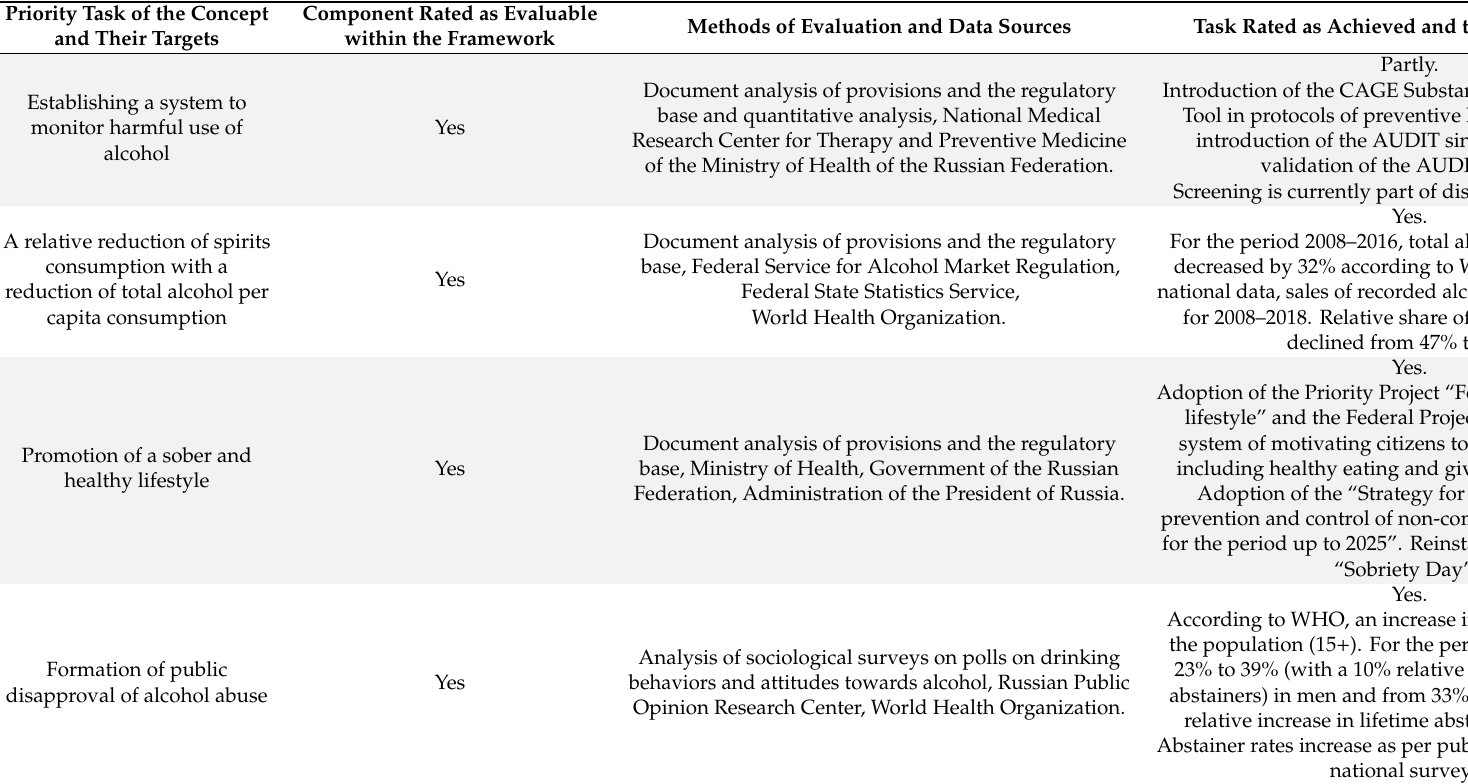
Table 2. Overview of the priority tasks of the concept, their targets, and rated rate of achievement (e ff ect